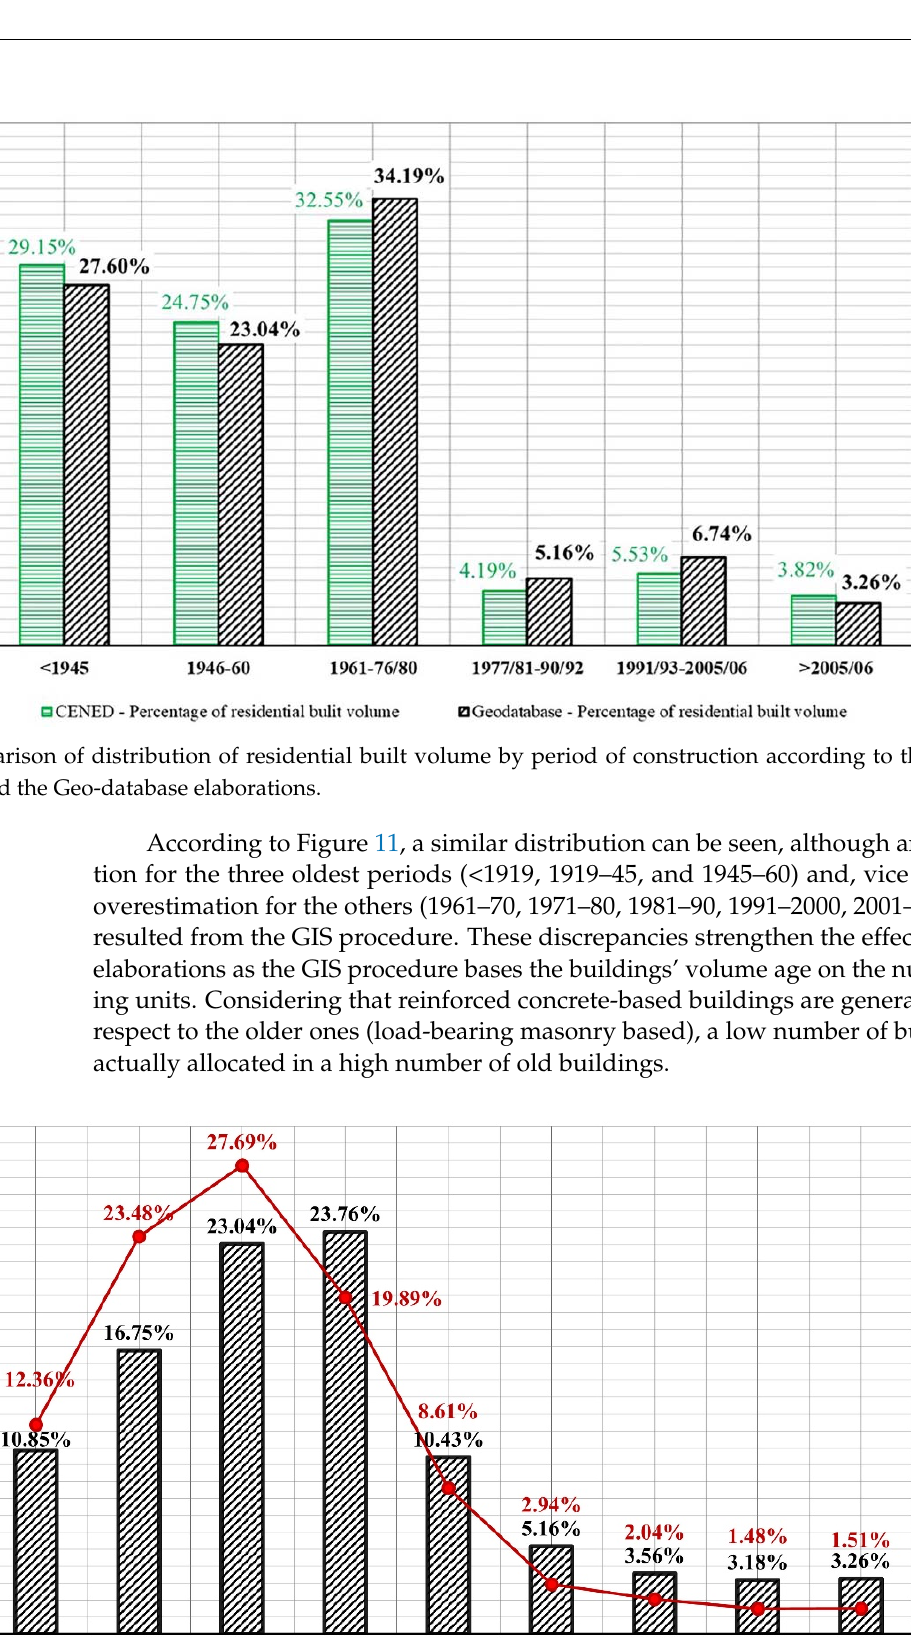
Figure 11. Comparison of distribution of residential stock by period of construction according to the Istat municipal data and the Geo-database elaborations.